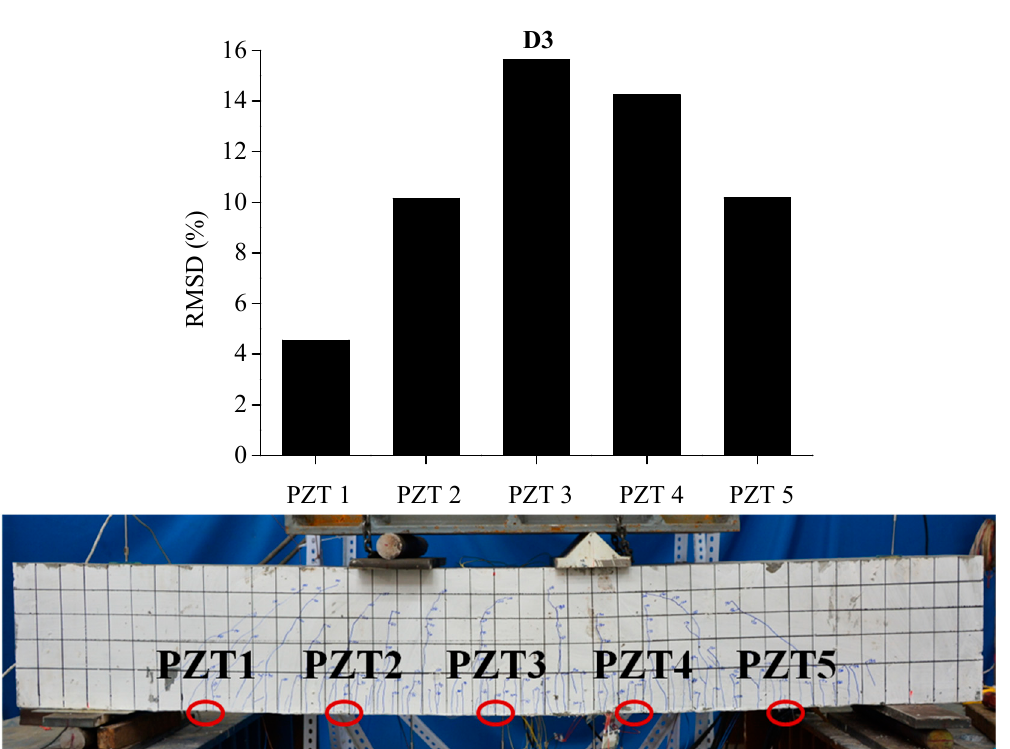
Figure 18. RMSD of each PZT sensor at D3 and the related cracking pattern of BE2.